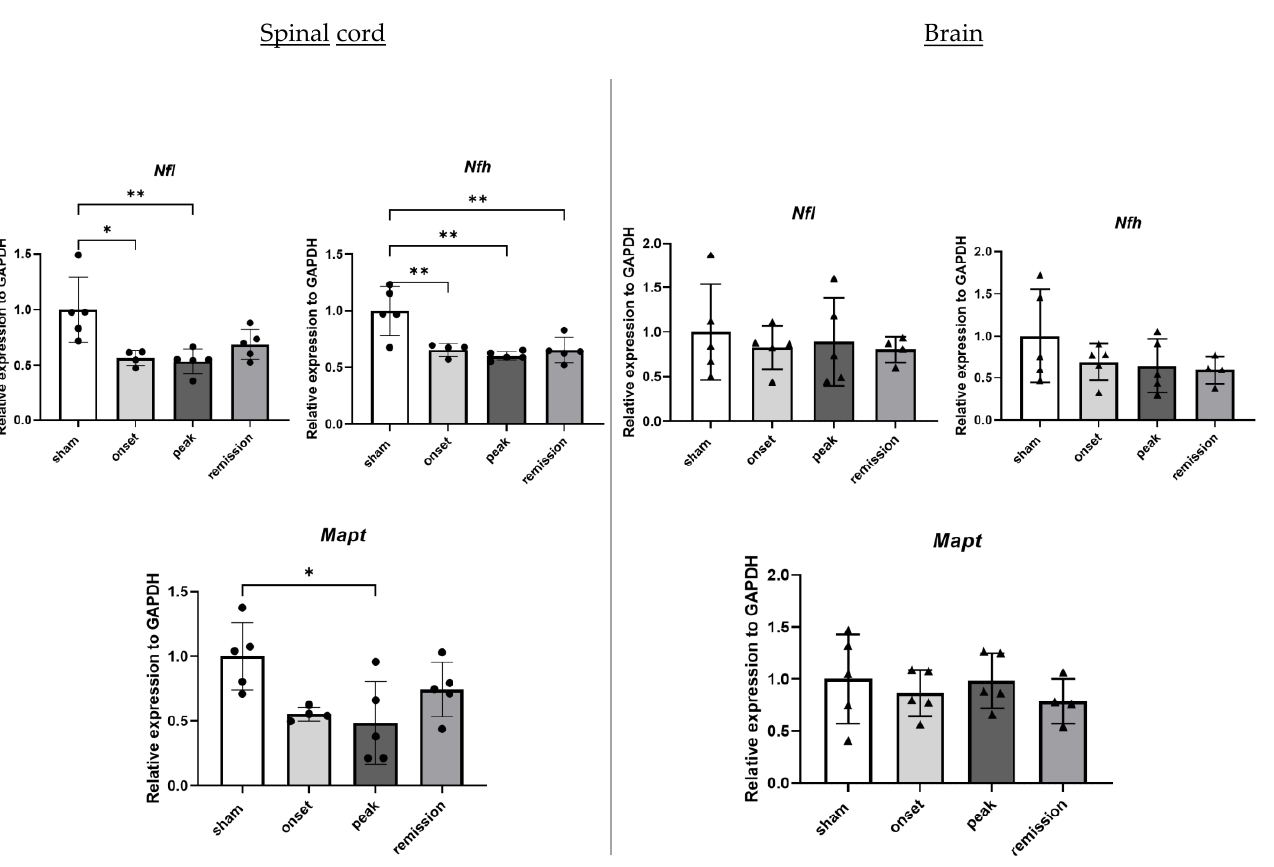
Figure 5. Differential expression of genes representative of neuronal damage in CNS organs during the different phases of PLP-induced EAE. The levels of mRNA transcripts for the selected genes relative to Gapdh were measured in the spinal cord ( left ) and brain ( right ) samples isolated from adjuvant controls and EAE mice on the onset, peak, and remission phases by RT-qPCR. A number of 3 to 5 mice was used in the experiment. Each symbol represents a sample. * p < 0.05, ** p < 0.01, one-way ANOVA.